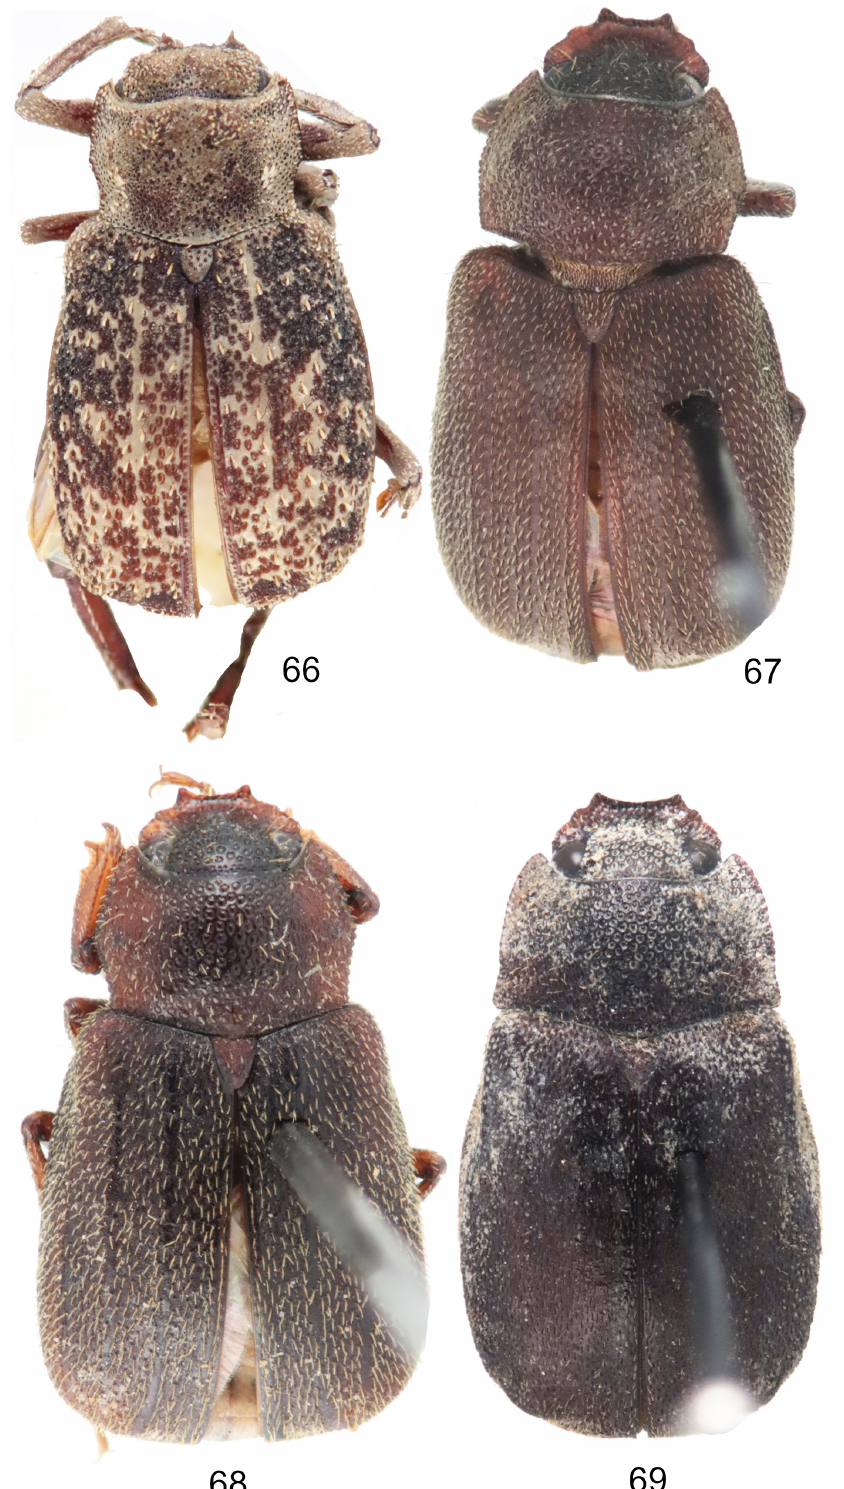
Figs 66–69. Papuan Maechidius Macleay, 1819, habitus, dorsal view. 66 . M. owenstanleyi sp. nov., holotype, ♂ (BMNH). 67 . M. paupianus Heller, 1910, lectotype, ♀ (SNSD). 68 . Same, paratype, ♂ ( M. arrowi Frey, 1969) (BMNH). 69 . M. parallelicollis Moser, 1920, lectotype, ♂ (ZMHB). Not to